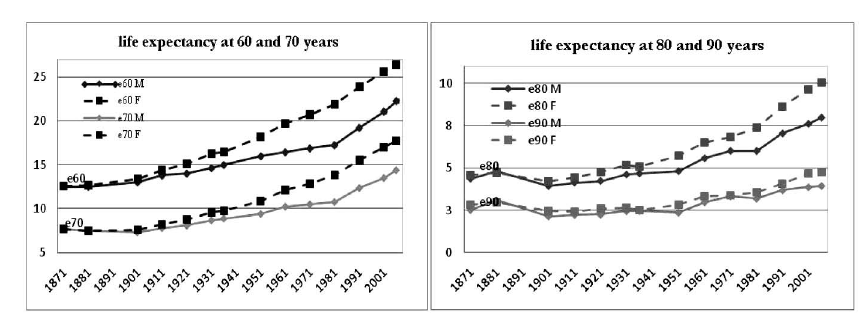
Figure 3 – Life expectancy at 60, 70, 80 and 90 years by gender (1871-2007).